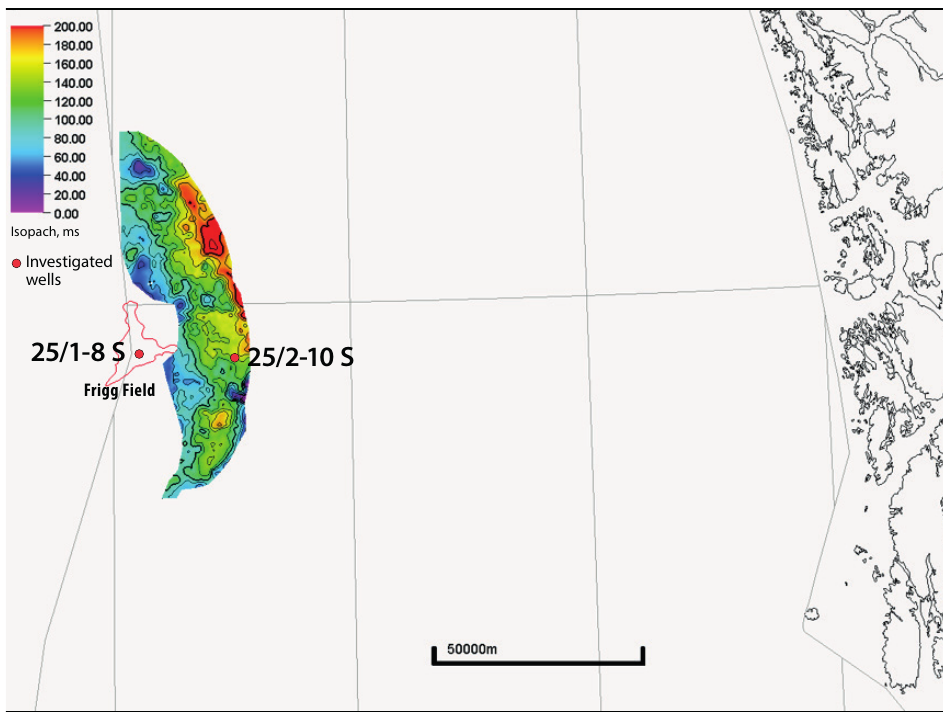
Figure 22. Thickness map of the Pleistocene deltaic sand (Snotra Formation) of the Nordland Group.